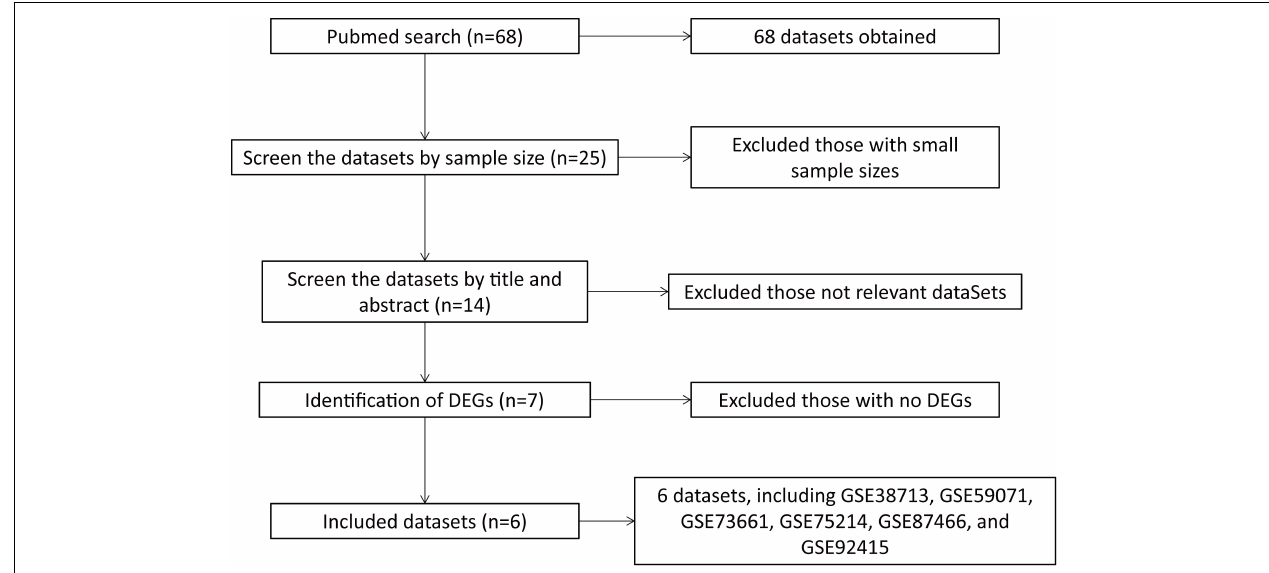
FIGURE 1 | Flowchart of dataset retrieval and